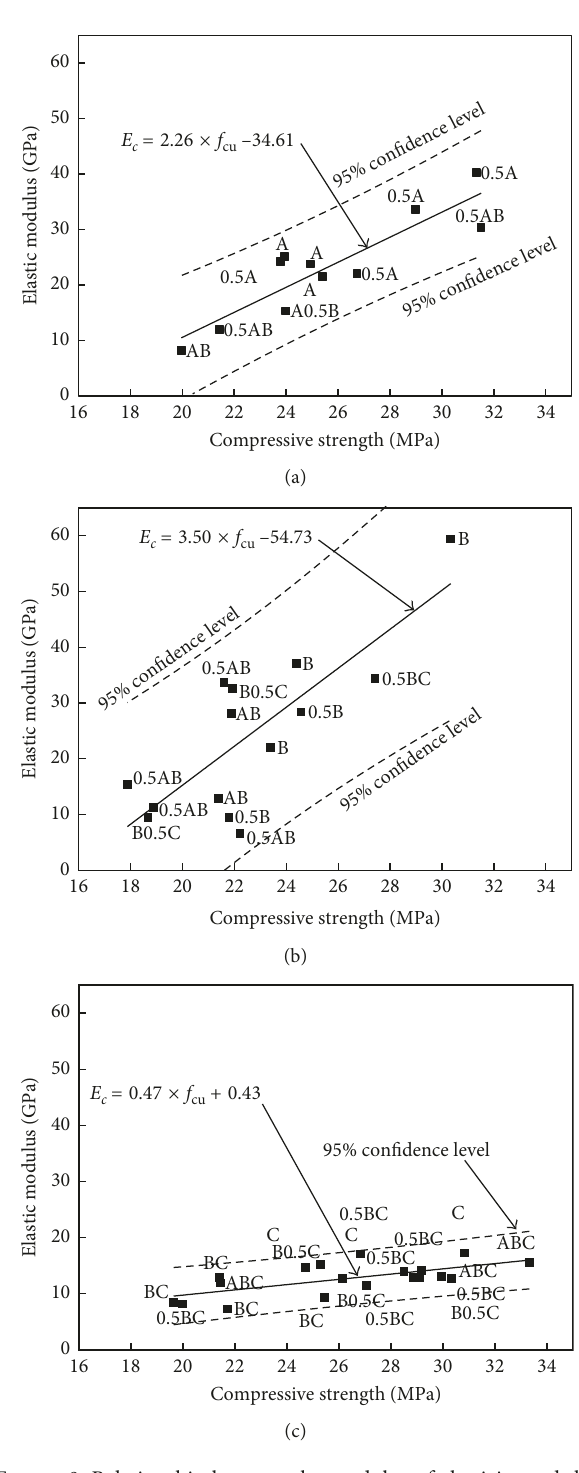
Figure 9: Relationship between the modulus of elasticity and the compressive strength of recycled aggregate concrete. (a) Concrete with aggregate group A, (b) concrete with aggregate group B, and (c) concrete with aggregate group